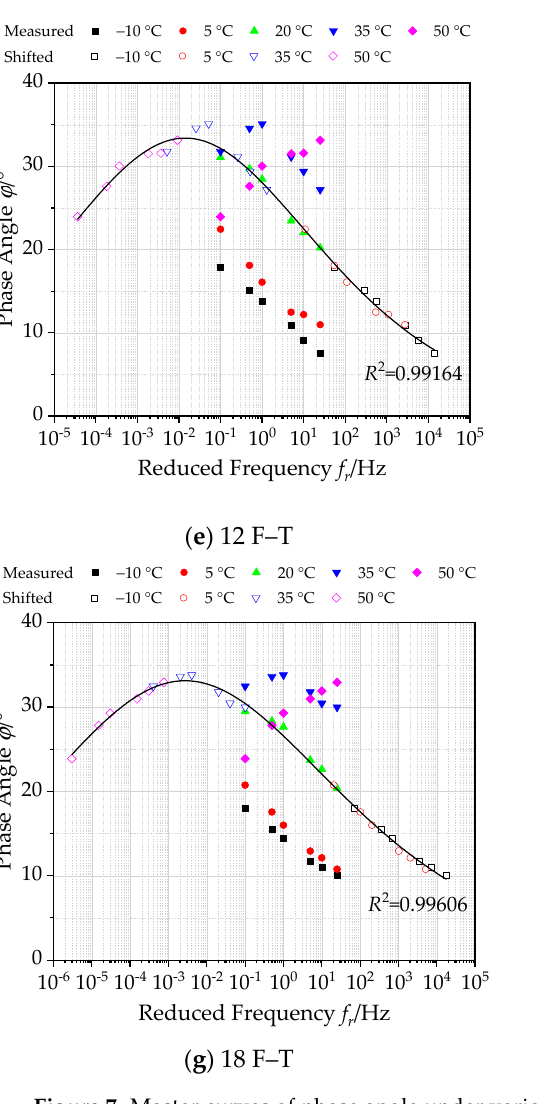
Figure 7. Master curves of phase angle under various F–T cycles (reference temperature = 20 ◦ C). Table 8. Parameters of master curve functions of phase angle under various F–T cycles.